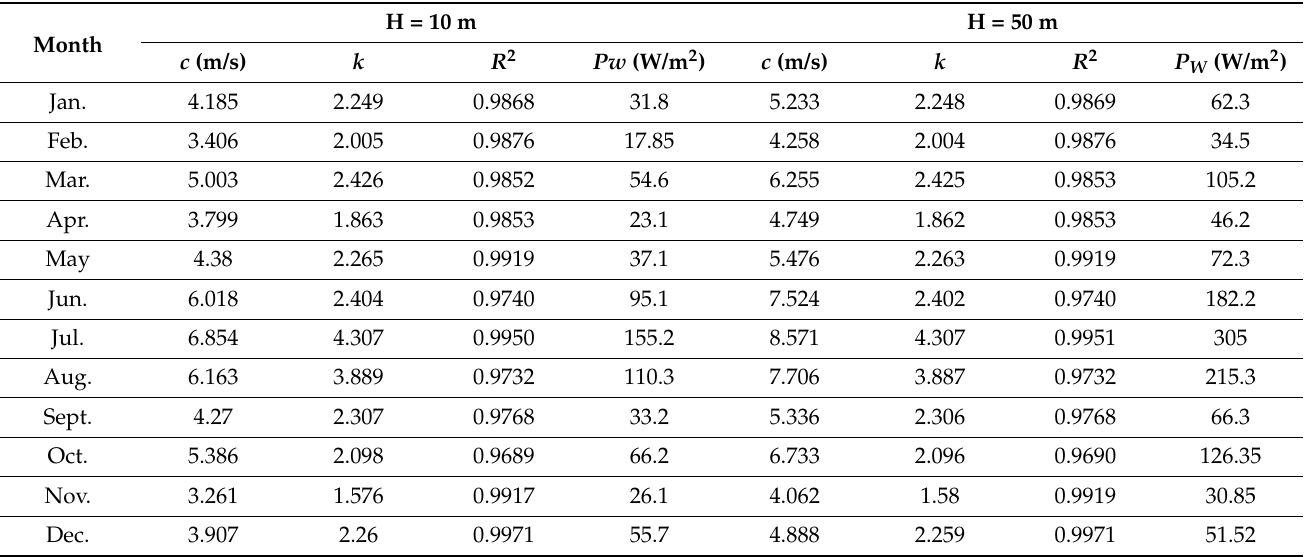
Table 10. The Weibull parameters by Mabchour’s Method (MMab) for RAWA city at 10 m and 50 m height,